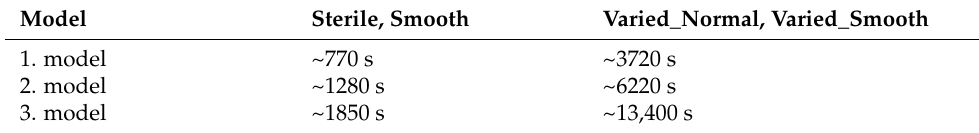
Table 7. The time needed for each model trained on each dataset for one epoch.